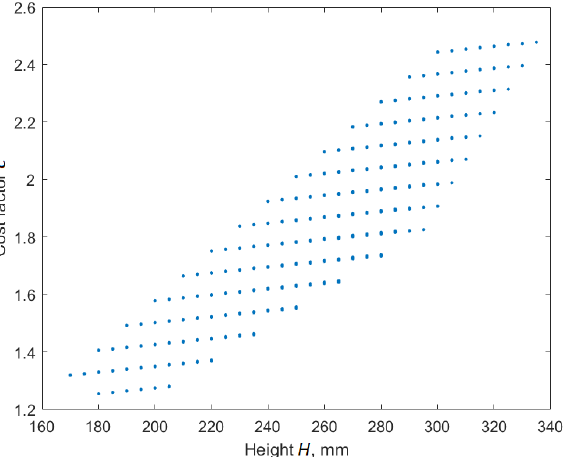
Figure 10. All possible results as the panel’s height with the related cost factor, which correspond to the ultimate and serviceability limit states for a CLT–concrete composite panel with a span of 7 m. Table 5. The most rational cross-sectional parameters of the CLT–concrete composite panel for category A1.